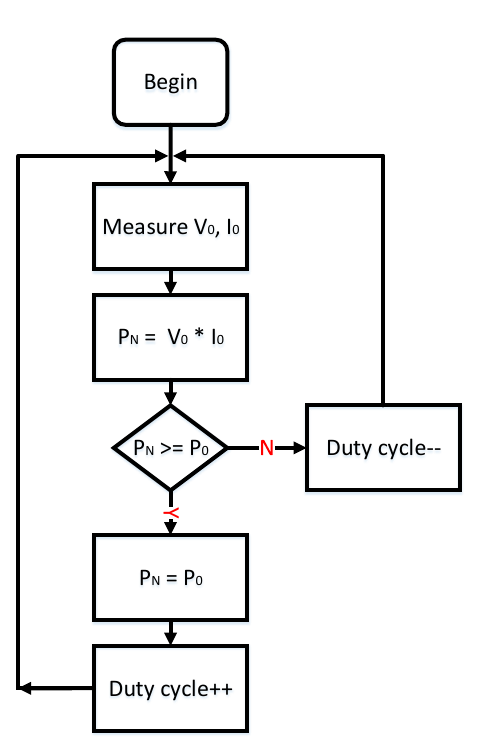
Figure 2. The MPPT algorithms control the duty cycle of the boost converter